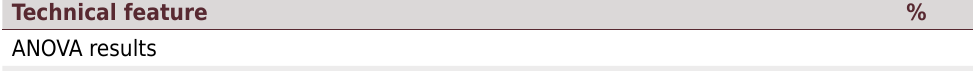
Table 4. Frequency of studies, in percentages of the total number of studies assessed, classified according to the quality of use of statistical procedures in soil science in Brazilian journals Technical feature